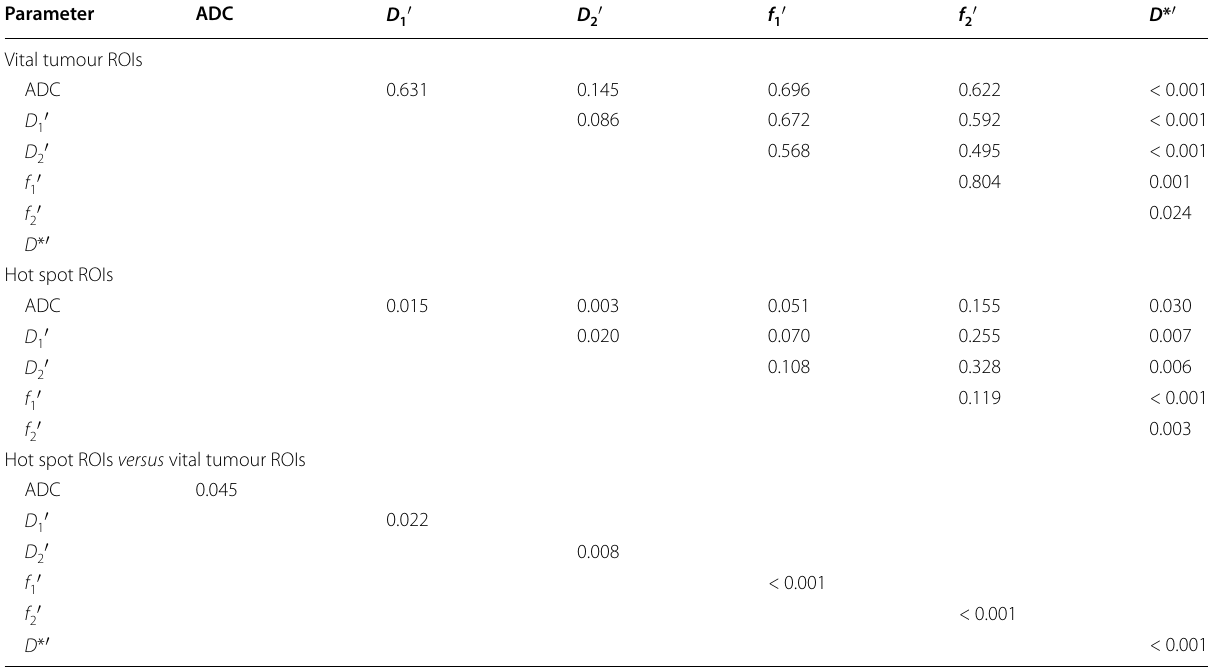
B versus group C +